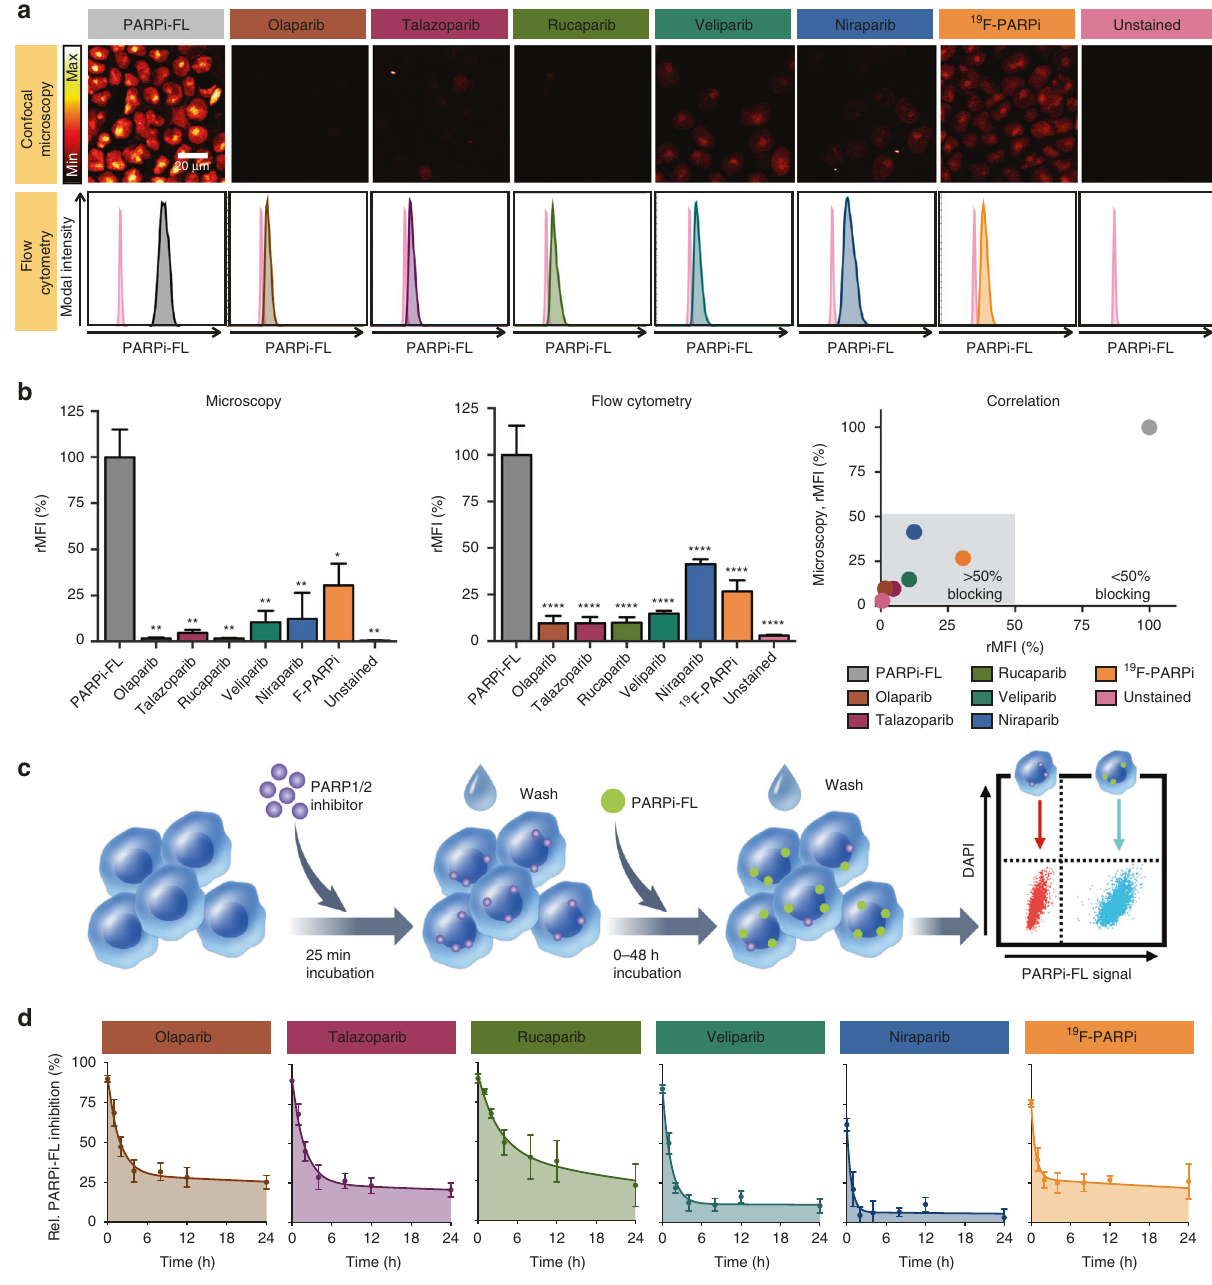
Fig. 3 PARPi-FL blocking and in vitro kinetics of different PARP inhibitors. a JHU-LX22 SCLC cells were treated with 6 different PARP inhibitors, including 5 clinical therapeutic inhibitors and a cold, non-radioactive analog of the PARP PET tracer, [ 18 F]PARPi. Cells were then treated with fl uorescent imaging agent PARPi-FL and either imaged via confocal microscopy or measured via fl ow cytometry. Microscopy (top) and fl ow cytometry (bottom) showing reduced PARPi-FL uptake in all cells treated with PARP inhibitors. b Quanti fi cation of PARPi-FL uptake with microscopy (left), fl ow cytometry (middle) and correlation between the two (right). c JHU-LX22 cells were incubated with one of 5 PARP inhibitors (olaparib, talazoparib, rucaparib, veliparib, niraparib, and 19 F-PARPi) at a concentration of 0.2 µ M for 25 min at 37 °C, and washed. After a post-incubation time of 0 – 48 h, cells were incubated with 0.2 µ M PARPi-FL for 15 min at 37 °C, followed by 10 min with medium to allow unbound compound to diffuse out of the cells. Then, cells were trypsinized, subjected to fl ow cytometry and analyzed for the relative PARPi-FL fl uorescence signal. Cells that had not been exposed to a PARP inhibitor served as control and were de fi ned as 0% relative PARP inhibition. d Decay curves were calculated with Prism using two phase decay least squares regression. Non- parametric Student ’ s t -test was used to calculate the statistics. * P < 0.05, ** P < 0.01, *** P < 0.001, **** P < 0.001. Error bars represent the SD of three independent experiments with three parallels